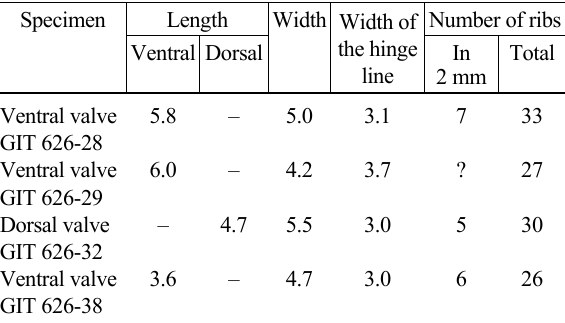
Table 3. Measurements (in mm) of Drabovia ? minuta sp. nov.